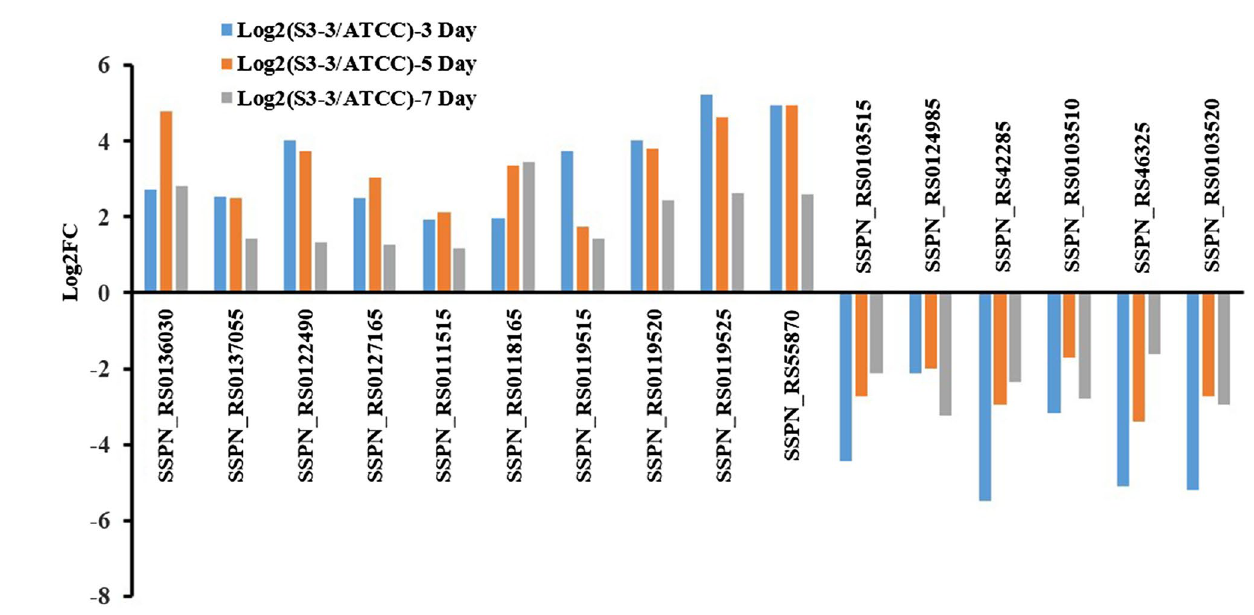
Figure 5. Transcriptional analysis of the genes related to glycometabolism pathway. The expression level of genes in S. spinosa ATCC_49460 was set as 1. (The chart was carried out using Microsoft Office Professional Plus